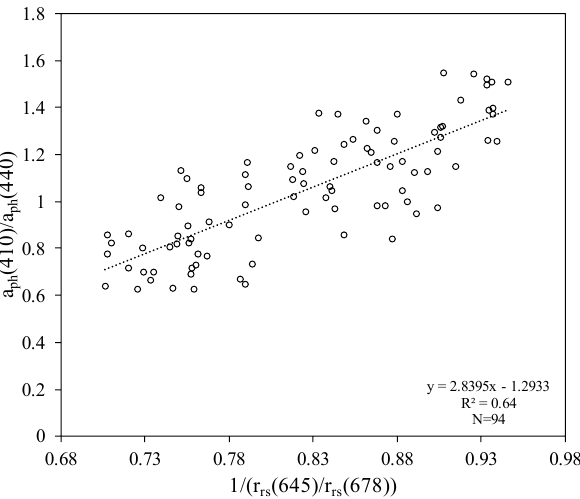
Figure 7. Model of relationship of below-surface remote sensing reflectance r rs (645) / r rs (678) with absorption coe ffi cients of phytoplankton a ph (410) / a ph